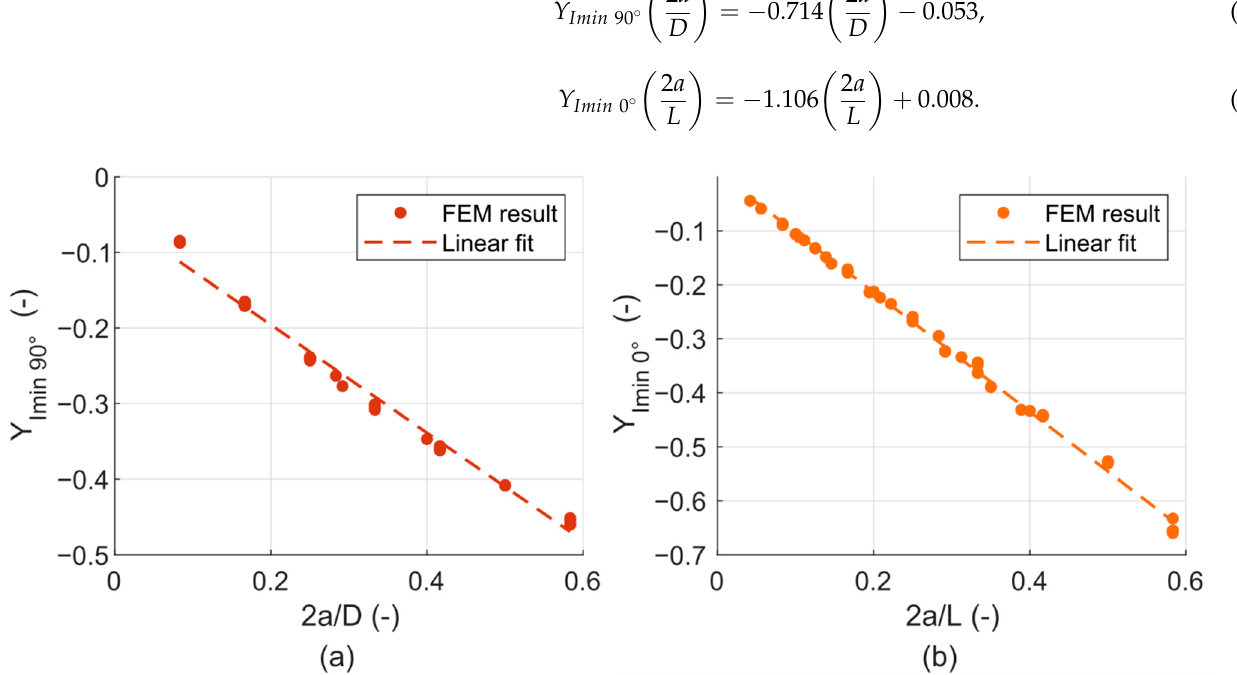
Figure 12. ( a ) Parametric functions fitting the values of Y Imin 90° ; ( b ) Parametric functions fitting the values of Y Imin 0° .